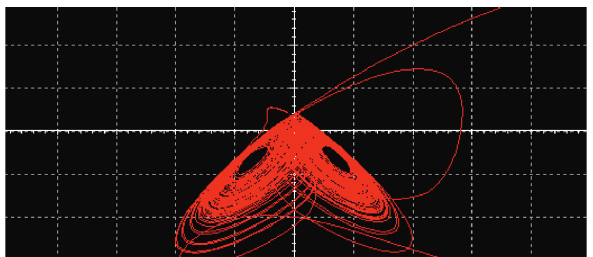
Figure 15: ( y, z ) space portrait of the Multisim simulation of equations (49)–(51).